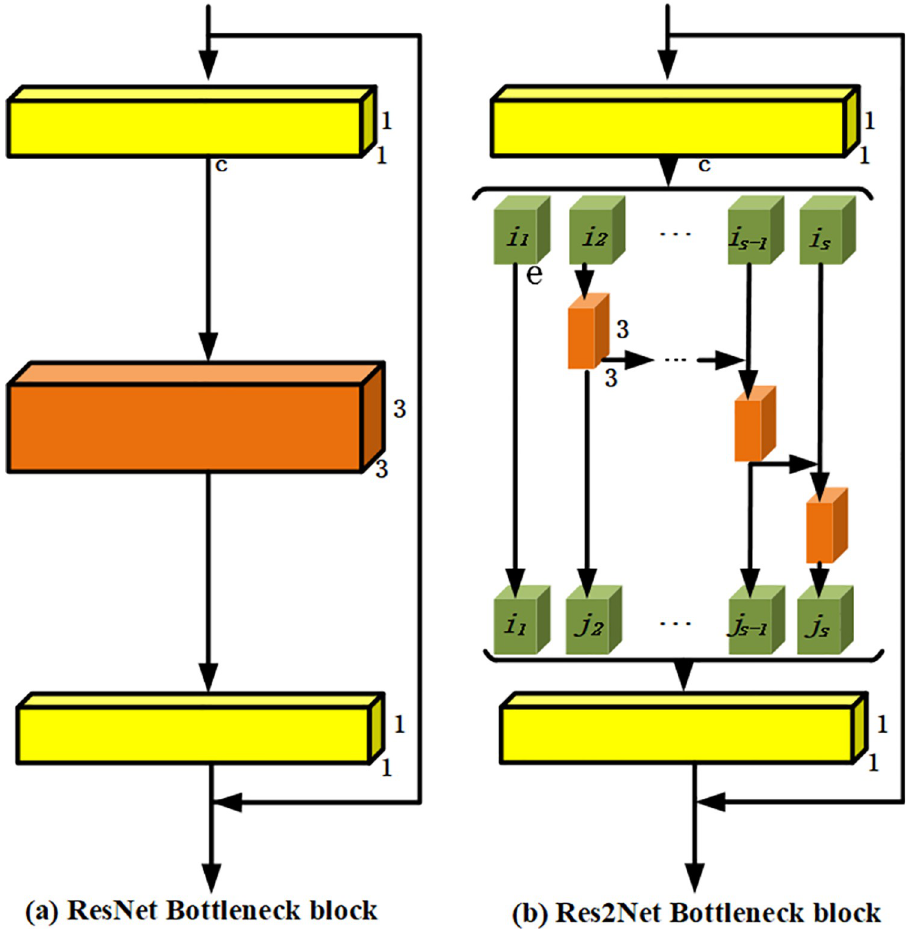
Fig 3. The structure diagram of